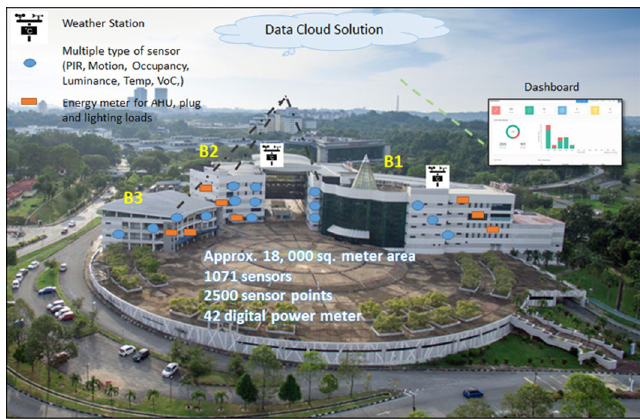
Fig. 5 IoT Living Lab at UNITEN Campus in